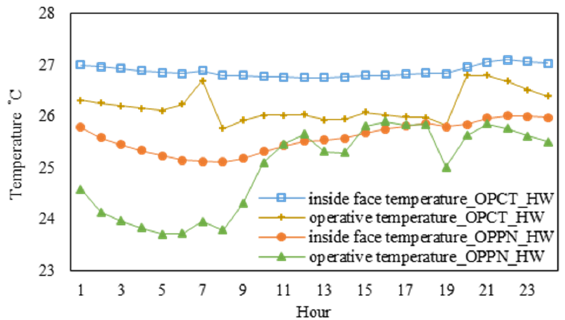
Figure 13. Indoor temperatures in the zones with ESCS in different operation strategies on a Beijing cooling design day.